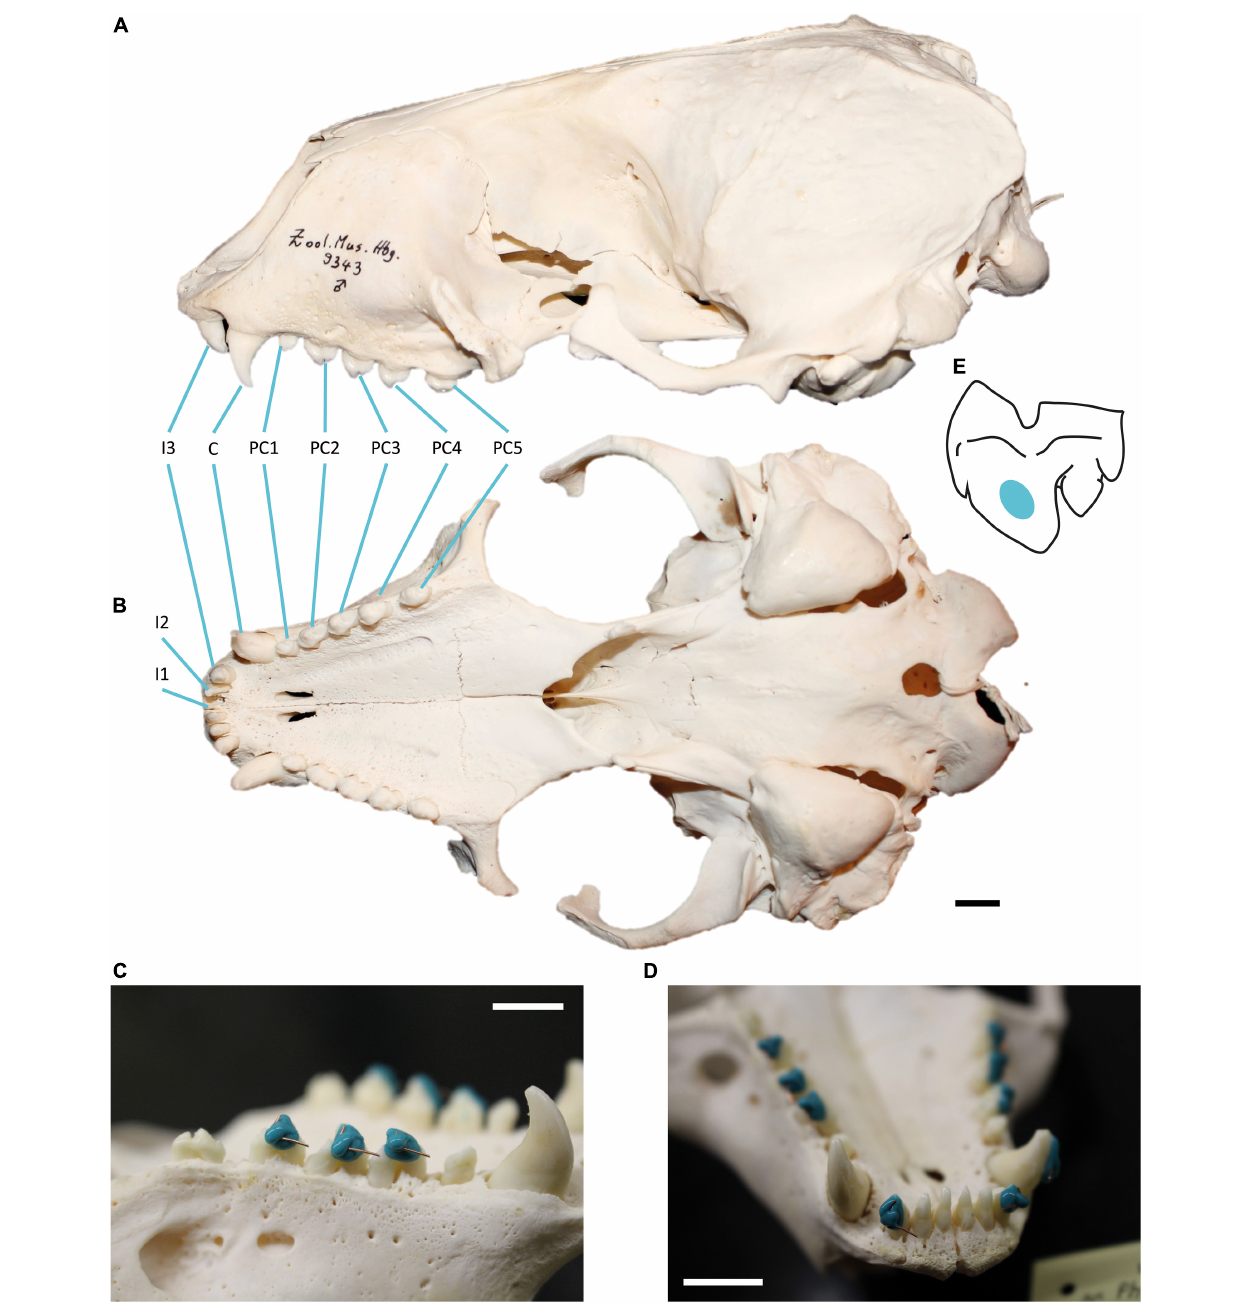
FIGURE 2 | Harbour seal ( Phoca vitulina ) dentition and moulding process. (A) Skull in ventral and (B) lateral view showing the upper dentition. Tooth positions from mesial to distal: first incisor (I1), second incisor (I2), third incisor (I3), canine (C), first postcanine (PC1), second postcanine (PC2), third postcanine (PC3), fourth postcanine (PC4), fifth postcanine (PC5). Specimen 9343, curated at Center of Natural History, Hamburg, Germany. (C) Moulding process on the buccal side of PC2, PC3 and PC4 and (D) on C and I3. The short wire is oriented towards cusp tip, the long wire towards mesial. Specimen 30670, curated at the skeletal collection of the Zoological Institute, University of Kiel, Germany. Scale = 1 cm. (E) Buccal view of measurement area (coloured) on the third upper postcanine tooth of Phoca vitulina